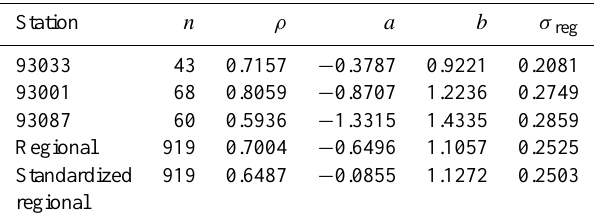
Table 4. Local and regional regression equations, n is the length of the observed data, ρ is the Pearson’s correlation coefficient, a and b are the parameters of the equation and σ reg is the standard deviation of the